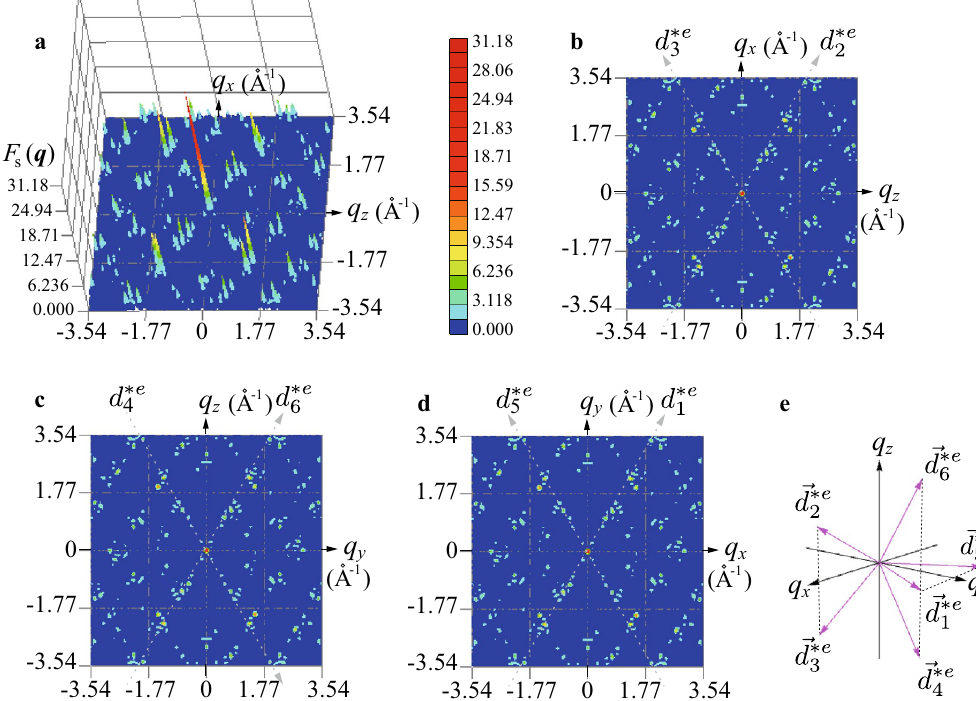
0 . ( b ) Top view of ( a ). ( c ) Top view of Figure 3. ( a ) Magnetic structure factor F s ( q ) in the q z − q x plane for q y = 0 . ( d ) Top view of F 0 . The gray dashed lines F s ( q ) in the q y − q z plane for q x s ( q ) in the q x − q y plane for q z = = with arrows in ( b ), ( c ), and ( d ) denote the pseudo 5-fold axis defined in ( e ). ( e ) Primitive vectors in the six- e 1, . . . , 6 ) as the physical (external) space dimensional reciprocal-lattice space d ∗ i ( i =